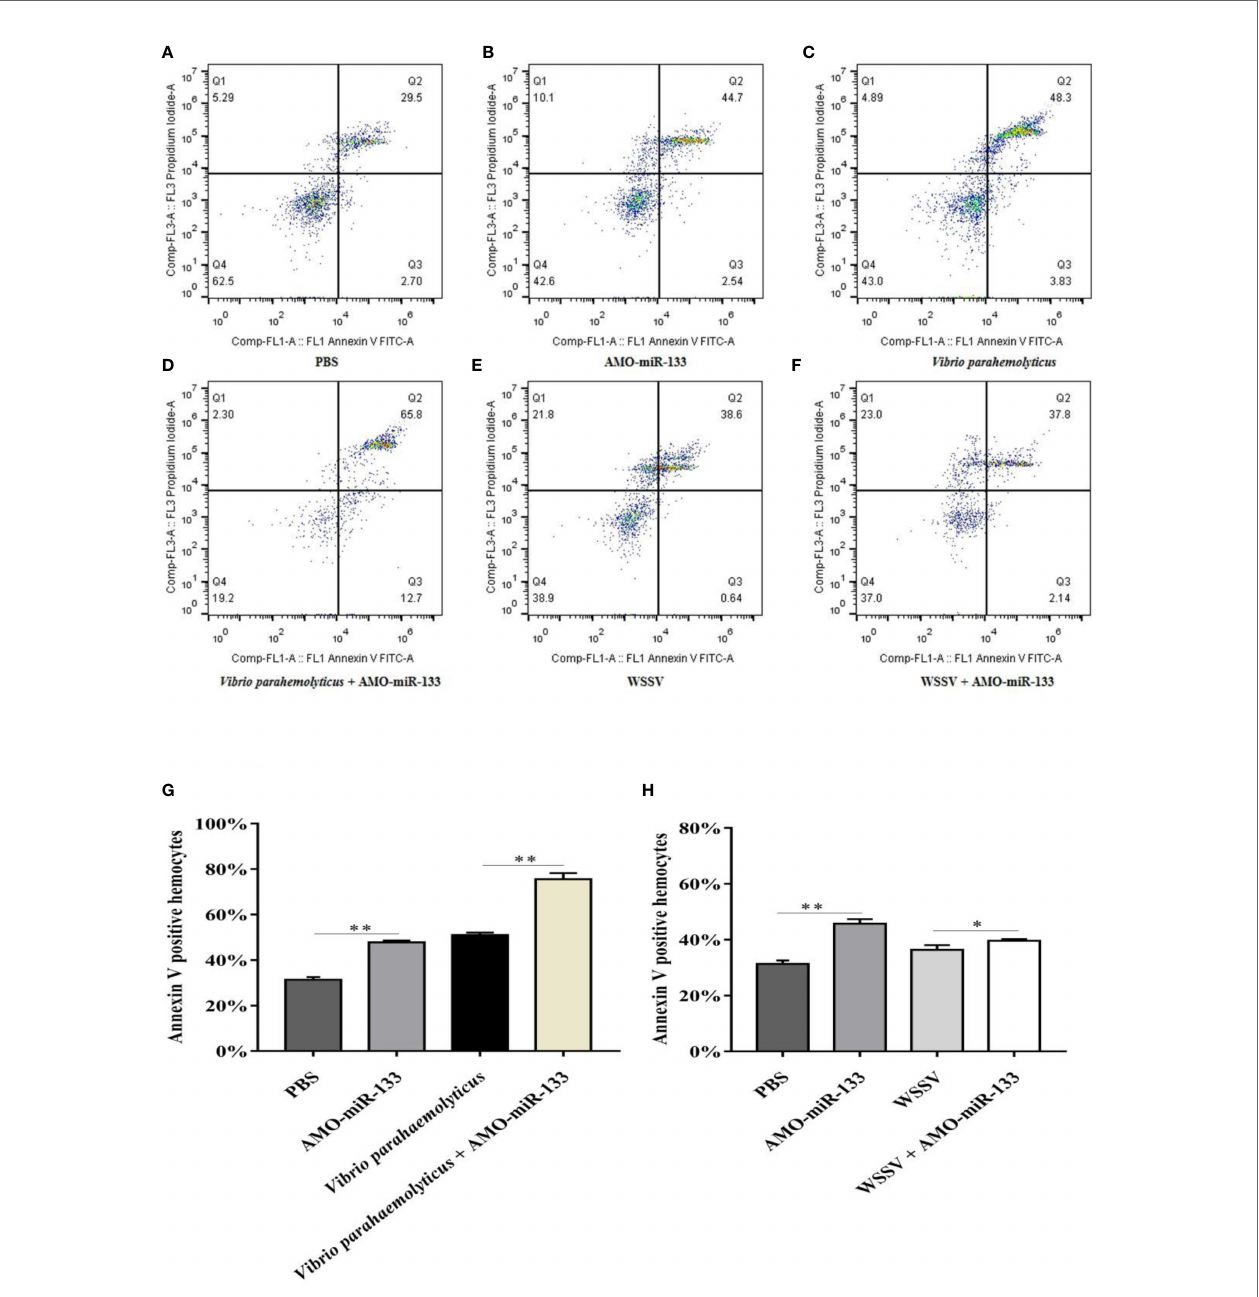
FIGURE 6 | Hemocyte apoptosis assay. (A) PBS group. (B) AMO-miR-133group. (C) V.o parahaemolyticus group. (D) V. parahaemolyticus + AMO-miR-133 group. (E) WSSV group. (F) WSSV + AMO-miR-133 group. (G) Bar graph of apoptosis after challenge with V. parahaemolyticus . (H) Statistical bar graph of apoptosis caused by WSSV infection. Signi fi cant difference between different samples is indicated by * P < 0.05 and ** P <